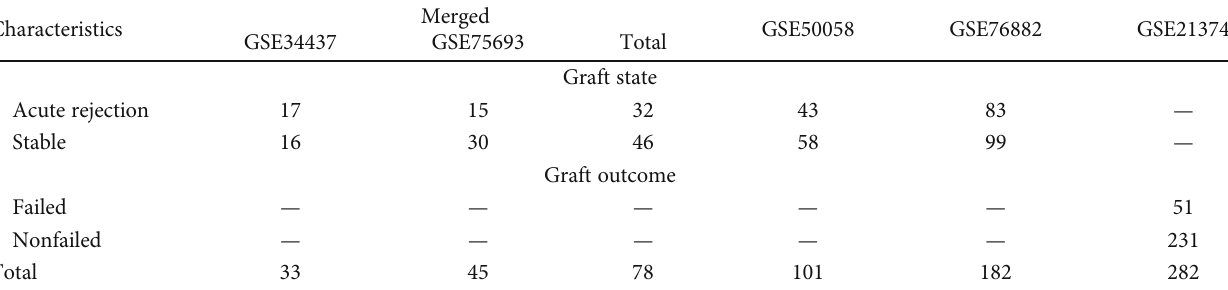
Table 1: Clinical characteristics of the GEO